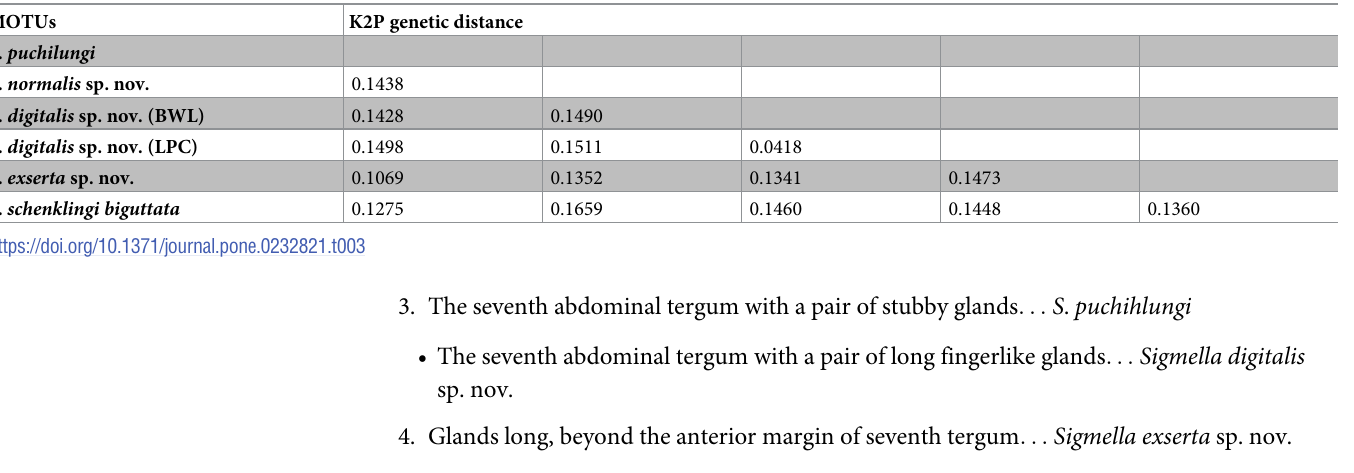
Table 3. K2P genetic distance among 6 Sigmella MOTUs.